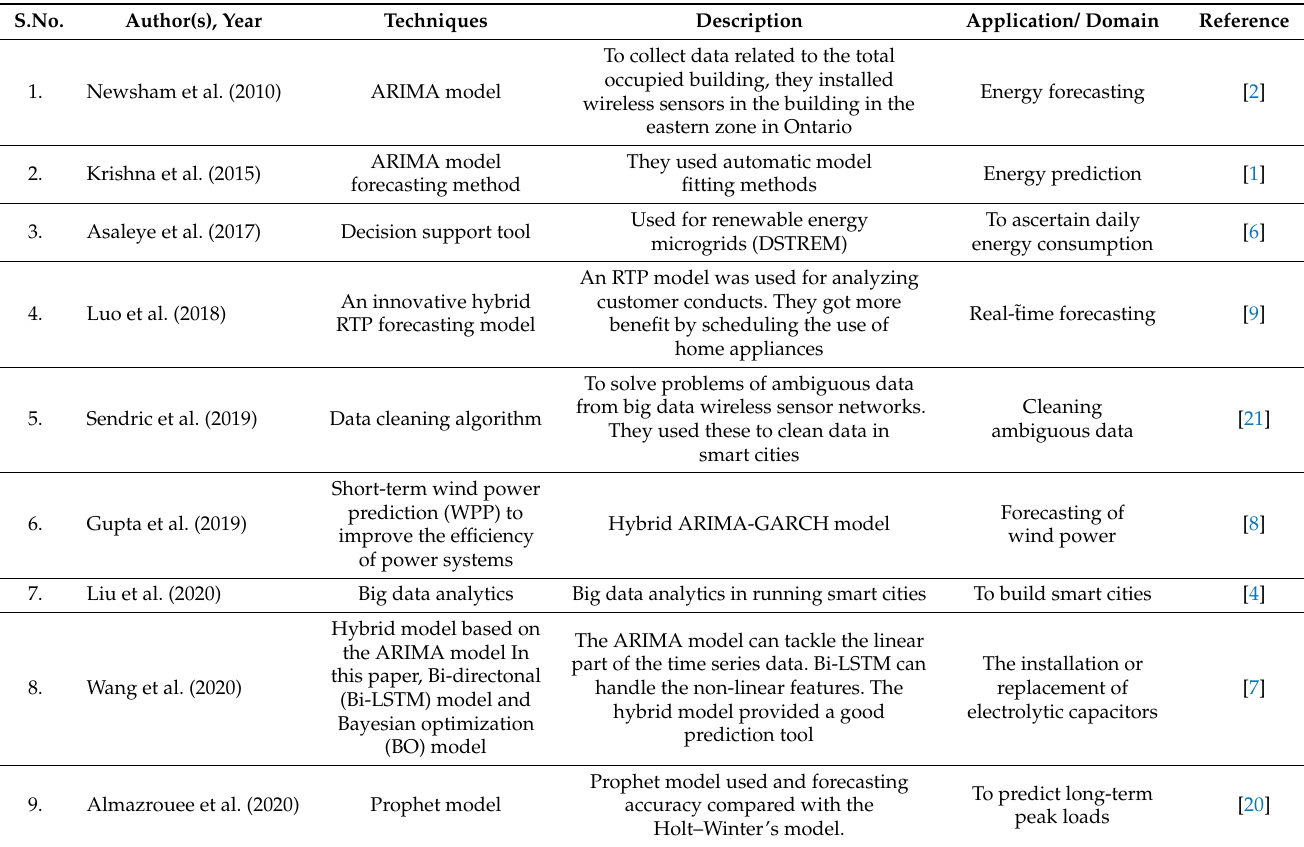
Table 1. Works related to energy forecasting for demand